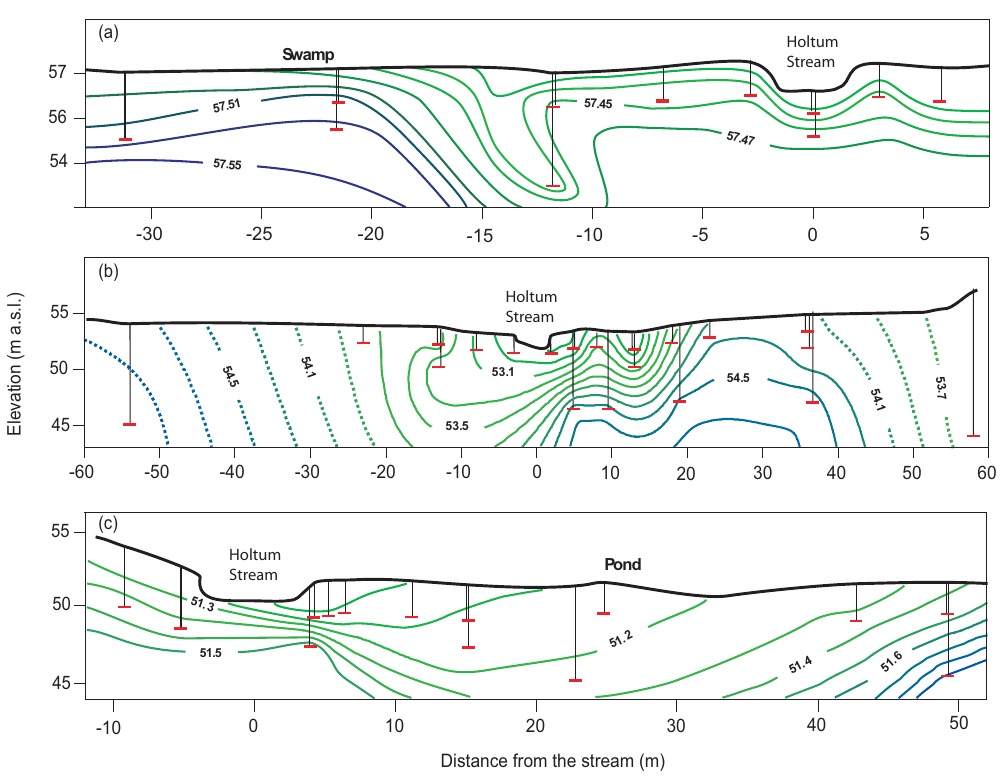
Figure 3. Manually interpolated cross-sectional contour maps of hydraulic heads. (a) Cross section at station 1 based on data from Febru- ary 2013. (b) Cross section at station 2 based on data from June 2013. (c) Cross section at station 4 based on data from March 2012. The horizontal red lines represent the screen depth of the piezometers where hydraulic heads were measured. Dashed isopotential lines indicate areas with sparse data